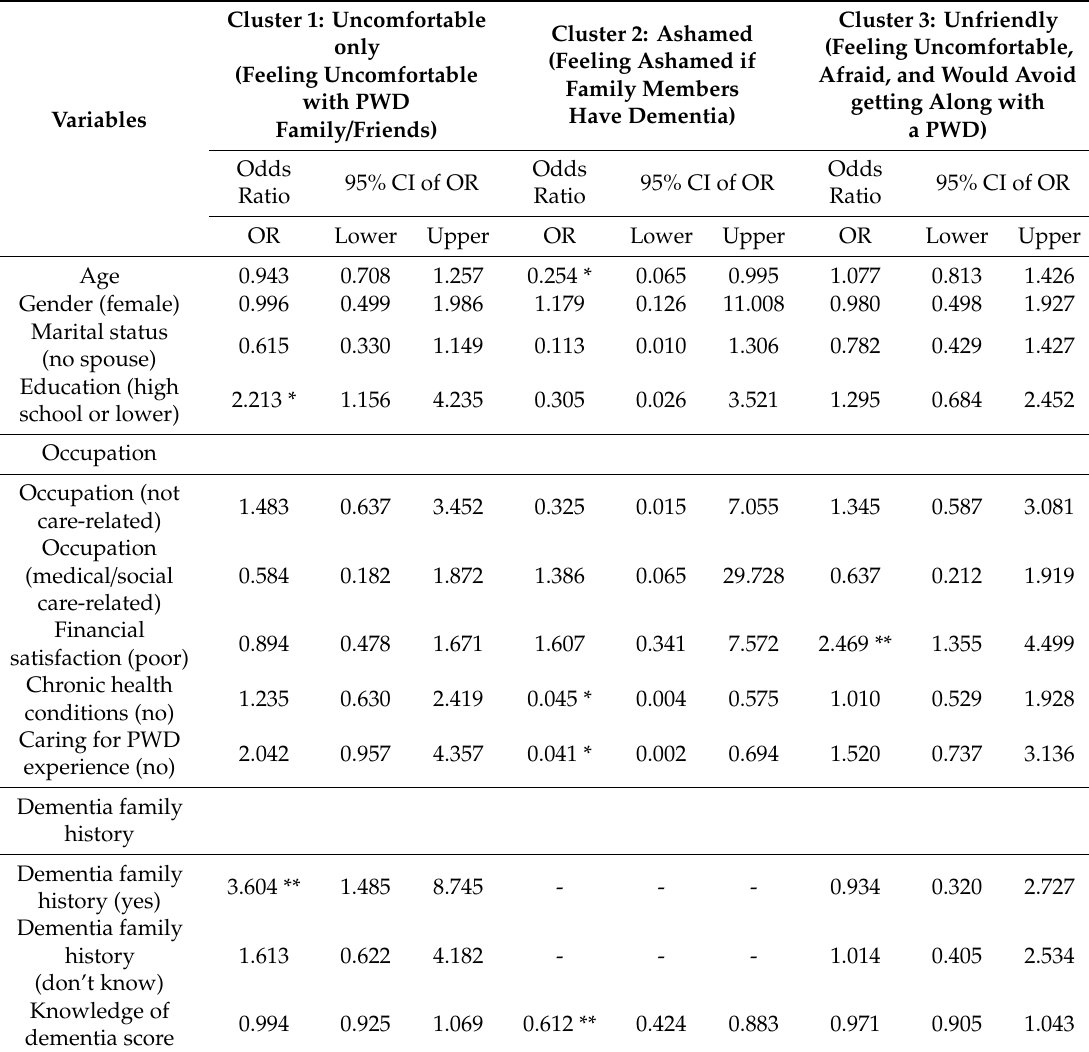
Table 4. Factors related to attitudes about dementia by multinomial logistic